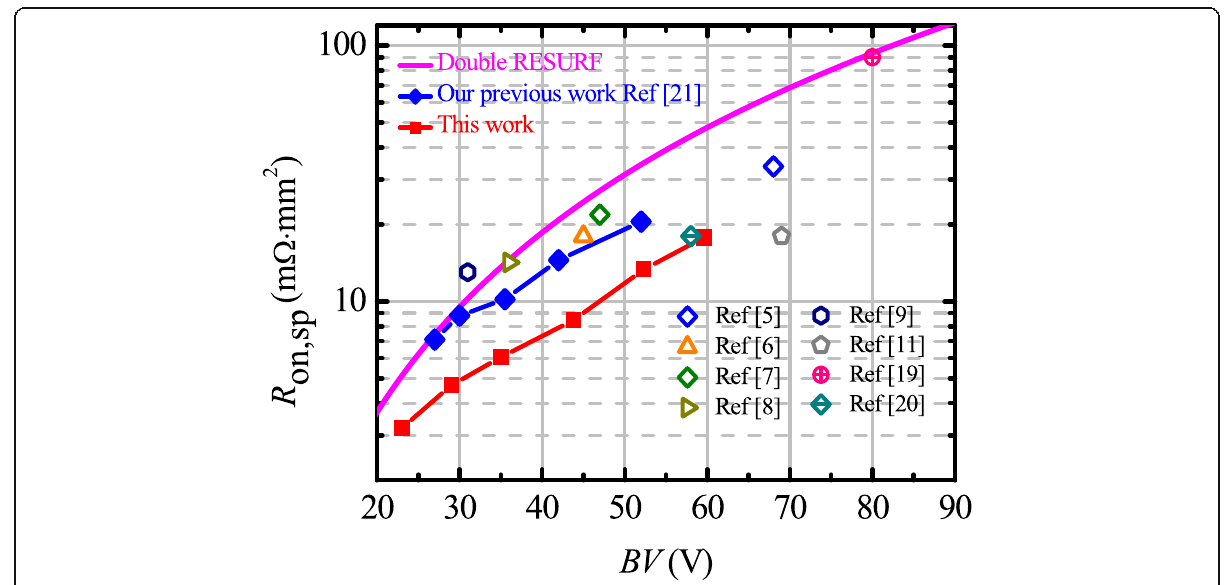
Fig. 6 The benchmark of existing BCD technologies and the proposed